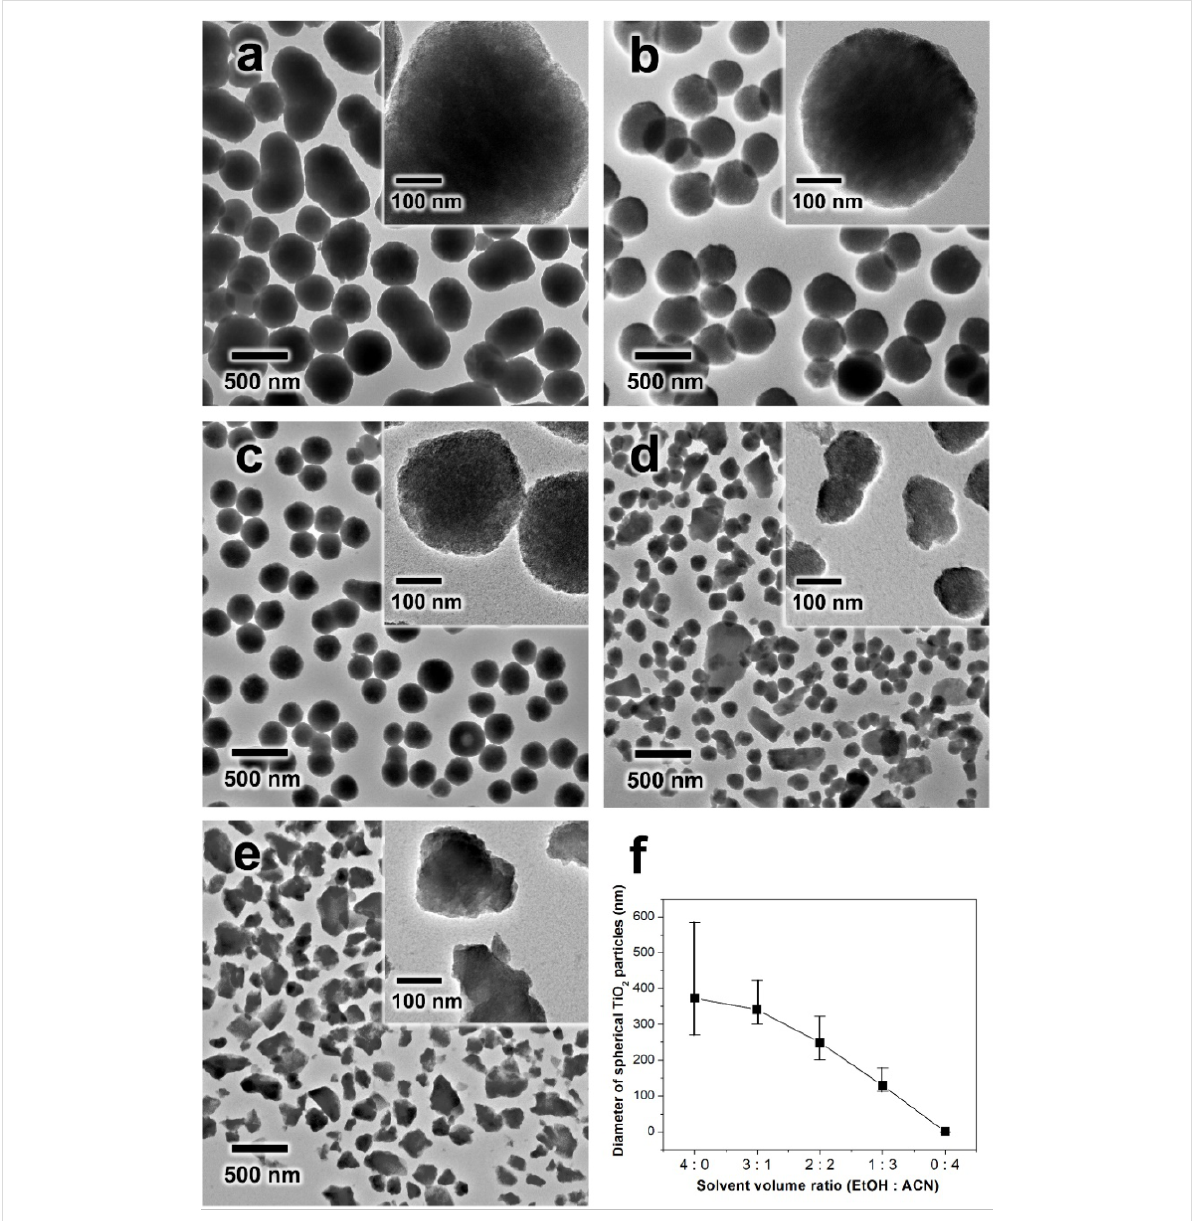
Figure 1: (a–e) TEM images of as-synthesized TiO 2 with different volume ratios of ethanol to acetonitrile used as the solvent: (a) ethanol/ACN 4:0 (b) ethanol/ACN 3:1 (c) ethanol/ACN 2:2 (d) ethanol/ACN 1:3 and (e) ethanol/ACN 0:4. (f) The relationship between the solvent volume ratio and the average diameter of the spherical TiO 2